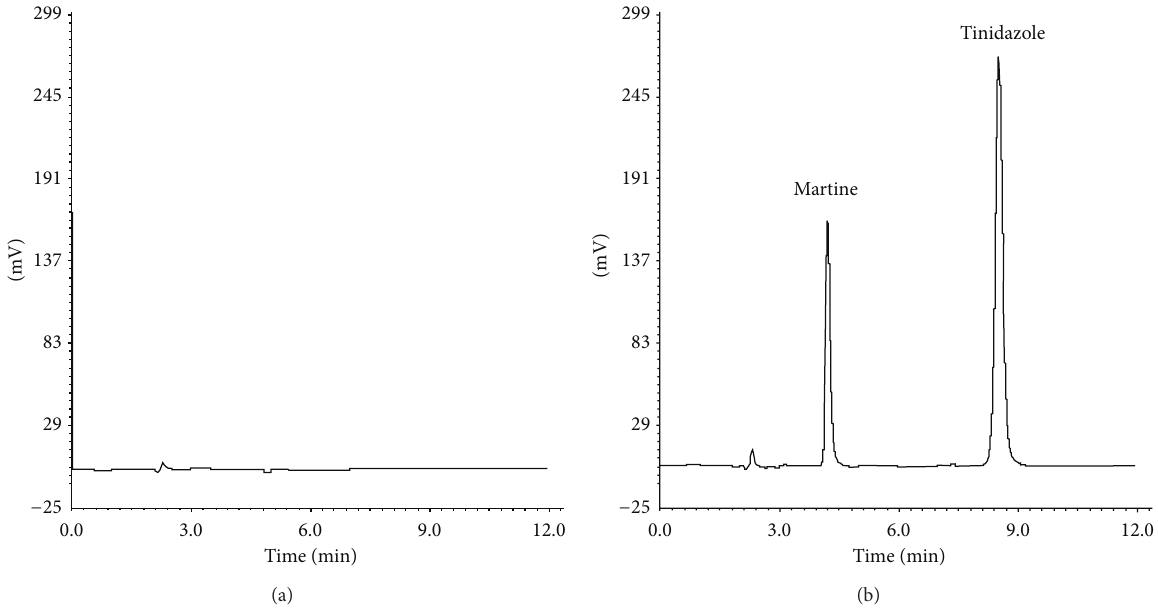
Figure 2: Typical HPLC chromatograms of (a) blank excipients sample and (b) compound lotion sample with matrine (50.0 𝜇 g/mL) and tinidazole (100.0 𝜇